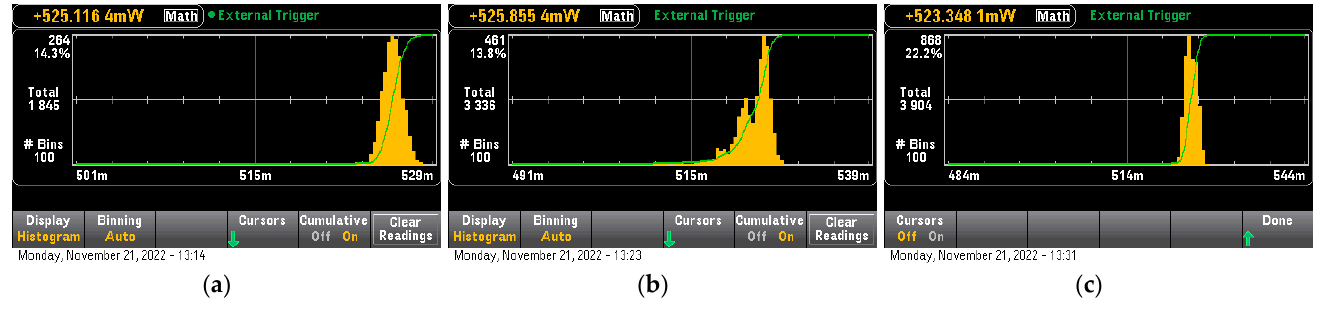
Figure 9. Sine Wave Prediction Model ( a ): Unoptimized, ( b ): Post Quantized, ( c ): Quantization Aware Trained. Table 2. Sine Model Results.